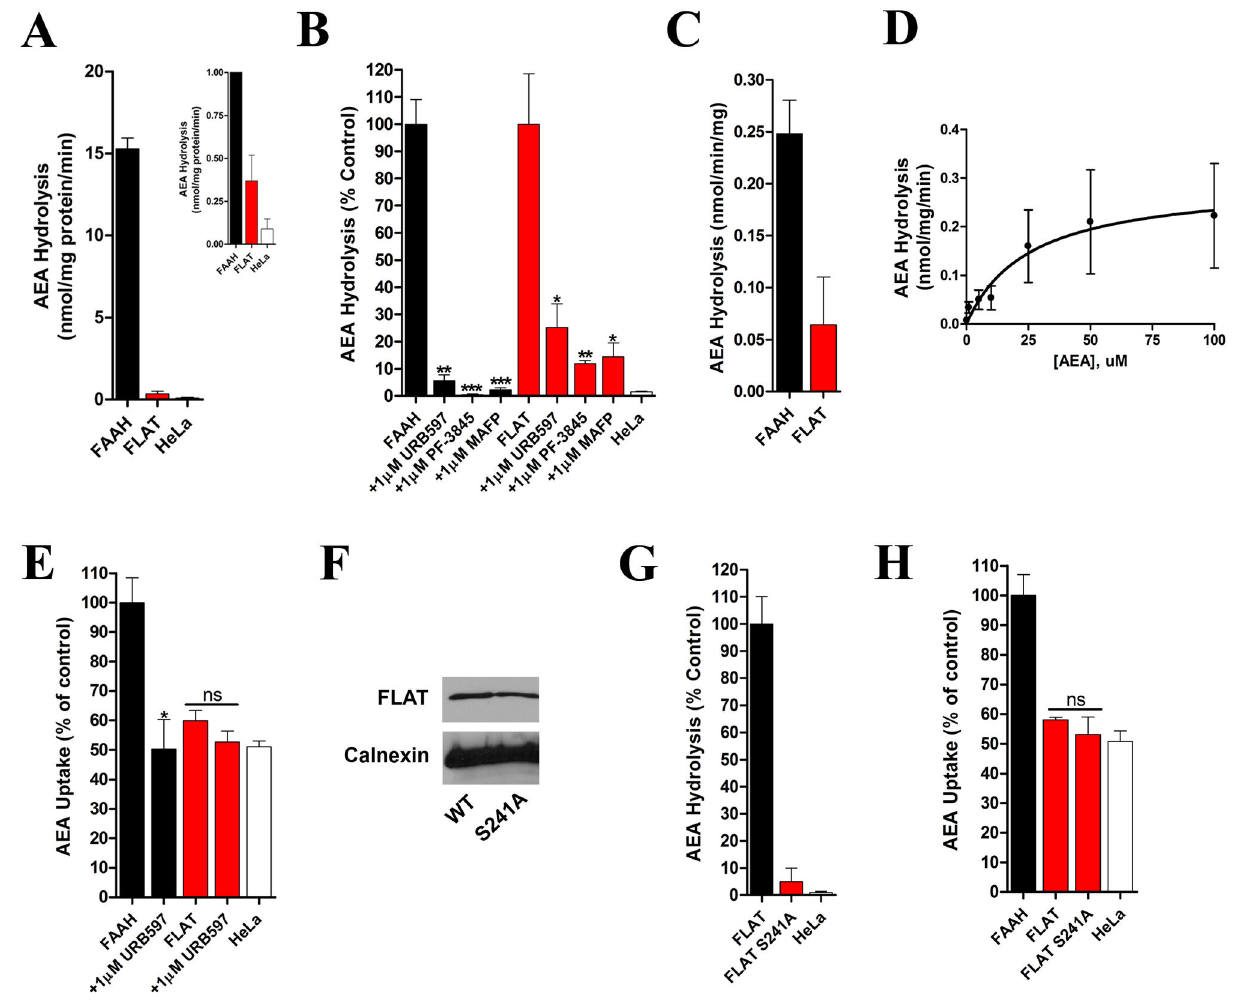
Figure 3. Effect of FLAT upon AEA hydrolysis and uptake. (A) AEA hydrolysis by HeLa cell homogenates transfected with FAAH or FLAT. Inset: Close up of AEA hydrolysis by FLAT-transfected and vector-transfected HeLa homogenates (n = 3). (B) Inhibition of FAAH and FLAT by URB597, PF-3845, and MAFP. *, p < 0.05; **, p < 0.01; ***, p < 0.001 (n = 3-5). (C) AEA (100 nM) hydrolysis by FLAT normalized to its expression level relative to FAAH (n = 3). (D) FLAT hydrolyzes AEA (0.1-100 µM) with a K 25.3 ± 14.2 µM and V of 0.29 ± 0.13 nmol/mg/min (n = 3-5). (E) AEA uptake in HeLa cells transfected with FAAH or FLAT in max